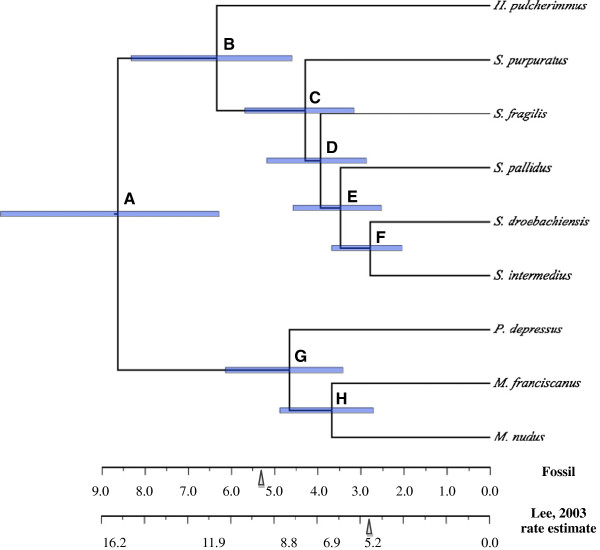
The molecular clock enforced dated phylogram from Bayesian Inference (BI) among fourfold degenerate sites from partial alignments of 2,562 nuclear genes without evidence of positive selection calibrated on fossil data. The Bayes Factor test shows no difference with the clock-enforced tree and clock-non-enforced tree. Blue 95% HPD node bars are filled according to posterior probability. Vertical arrows mark the approximate timing of the opening of the Bering Strait [69]. The scale bars denote time based on two dates of calibration based on the fossil record: 13–19 Ma at node A with 12S mitochondrial sequence (Lee, 2003 rate estimate’) [35] and 5–12 Ma at node C (‘Fossil’) [67].